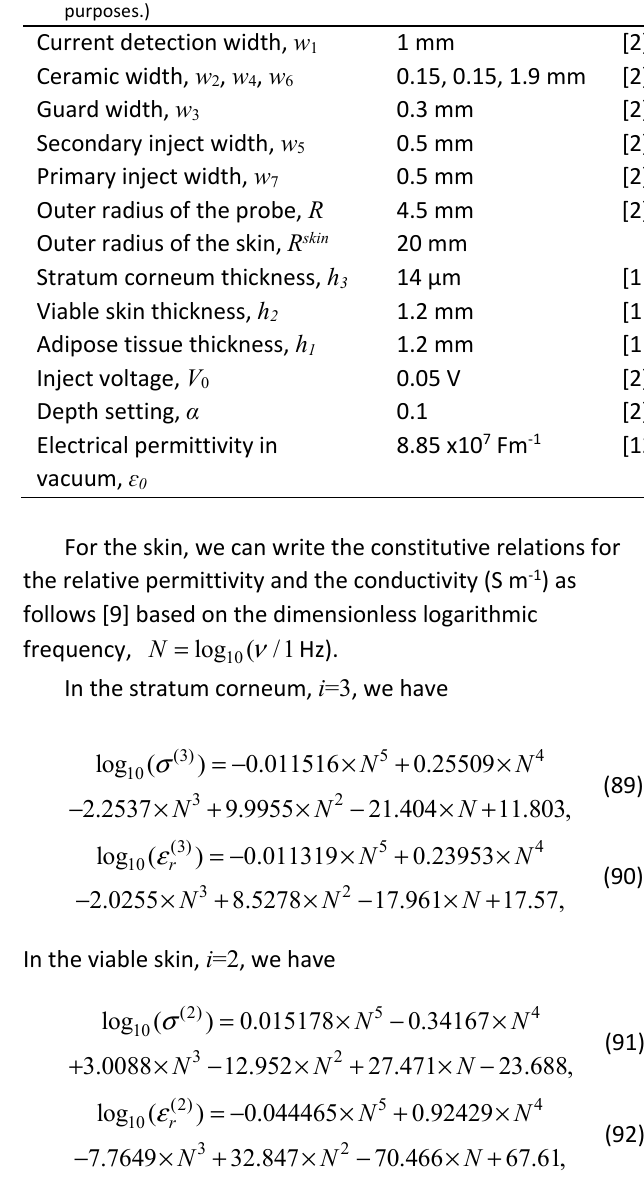
Tab. 1: Base-case dimensions and material parameters for the 4- electrode probe and 3 skin layers ( n =3 , m =4). (The outer radius of the skin is only used in the numerical solution for verification